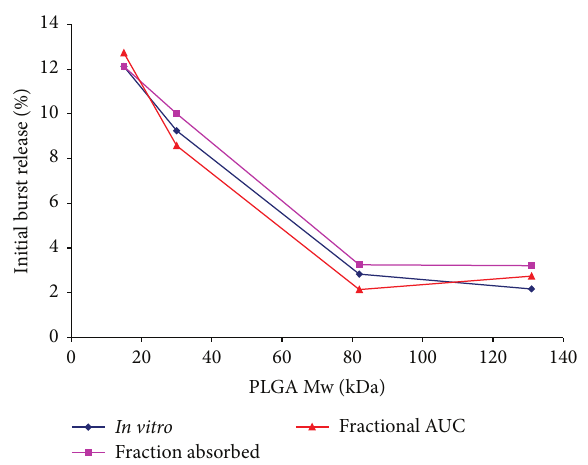
Figure 2: Effect of PLGA molecular weight on initial burst release of